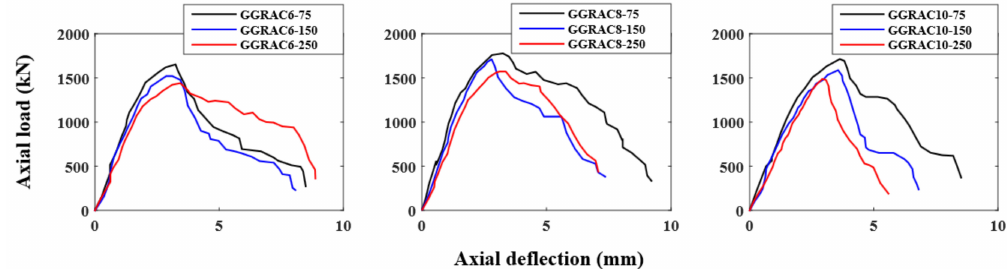
Figure 8. Influence of pitch of GFRP hoops on the load–deflection behavior of GGRAC compressive members.